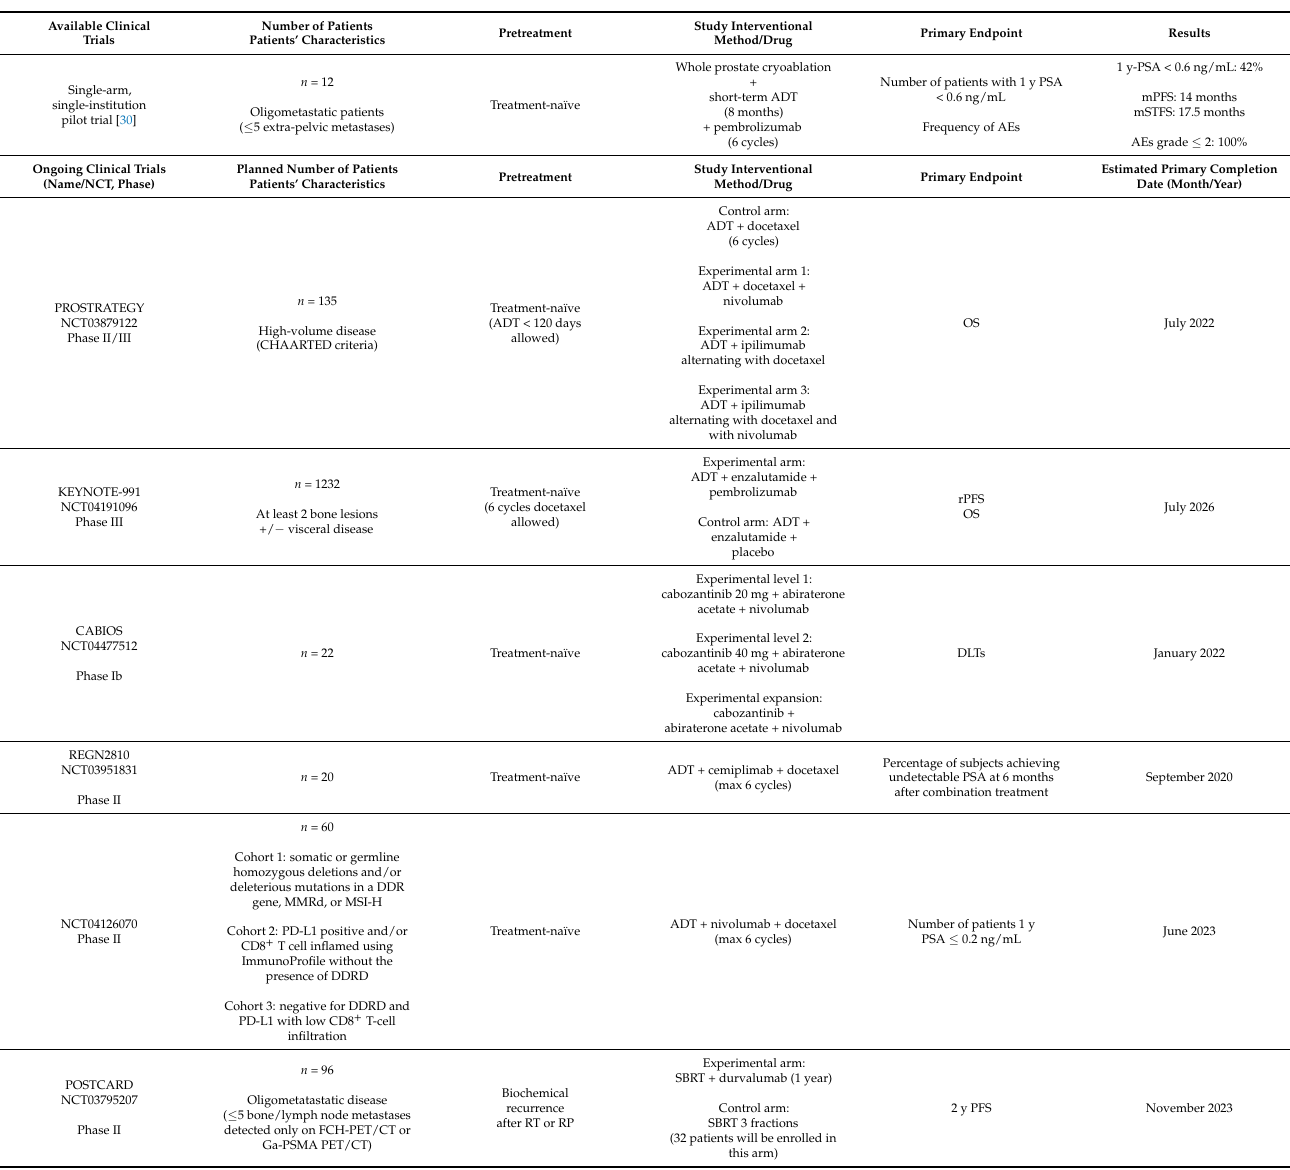
Table 1. Clinical trials on ICIs in locally advanced or metastatic HSPC